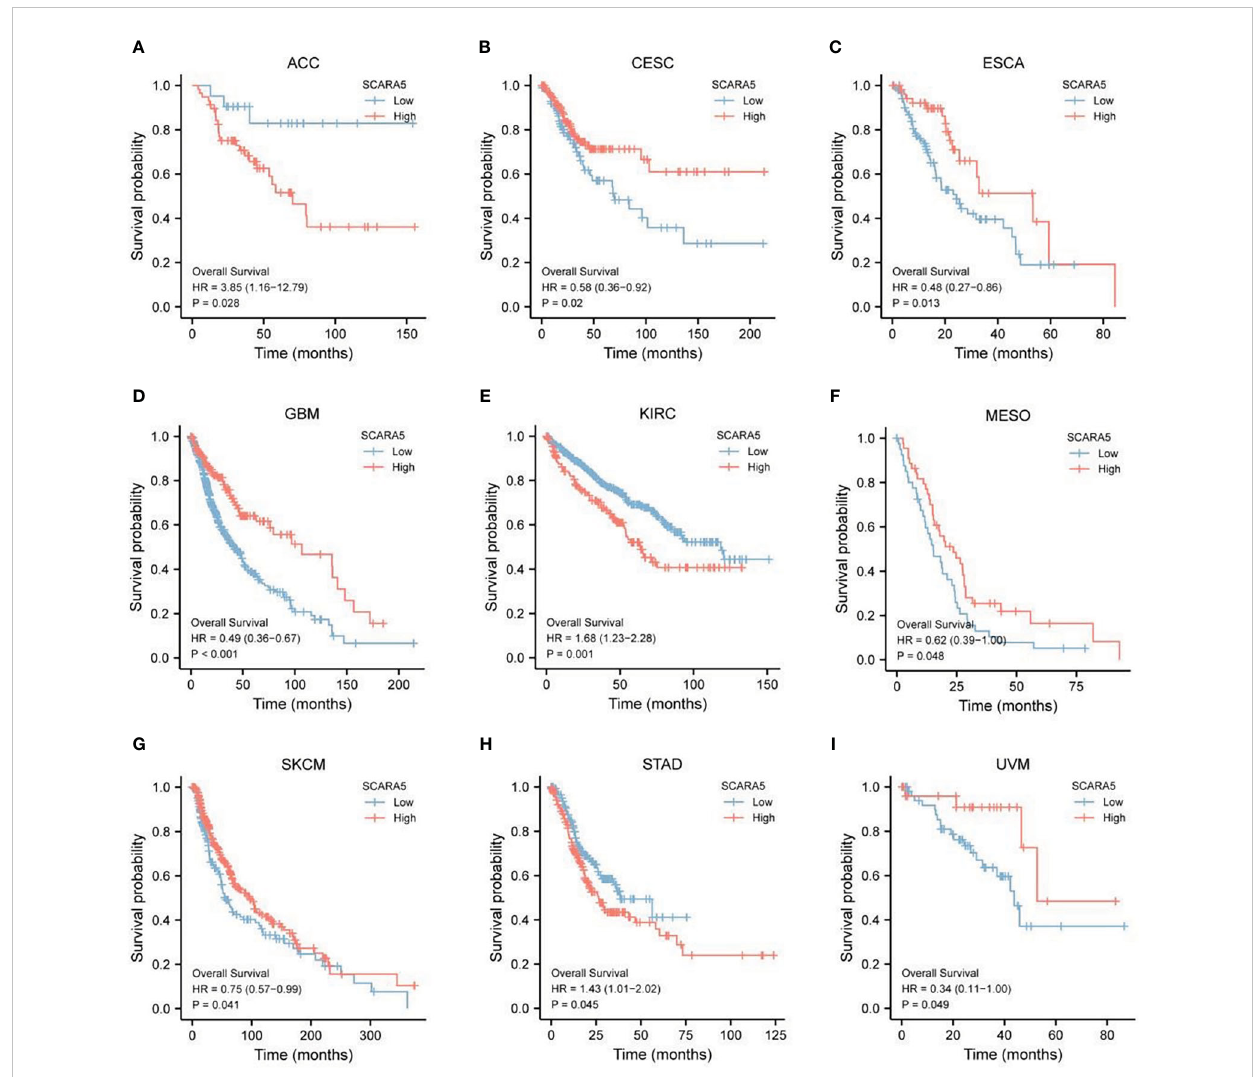
FIGURE 5 The Cancer Genome Atlas (TCGA)database https://portal.gdc.cancer.gov/) pan-cancer survival data for scavenger receptor class A member 5 ( SCARA5 ) expression was divided into a high expression group (50 – 100) and a low expression group (0 – 50). Log-rank test statistical method analysis, “ survminer ” was used for visualization, and it was found that the difference in survival time between SCARA5 groups in ACC, CESC, ESCA, GBM, KIRC, Skin cutaneous melanoma (SKCM), MESO, STAD, and UVM tumors was statistically signi fi cant (A – I)